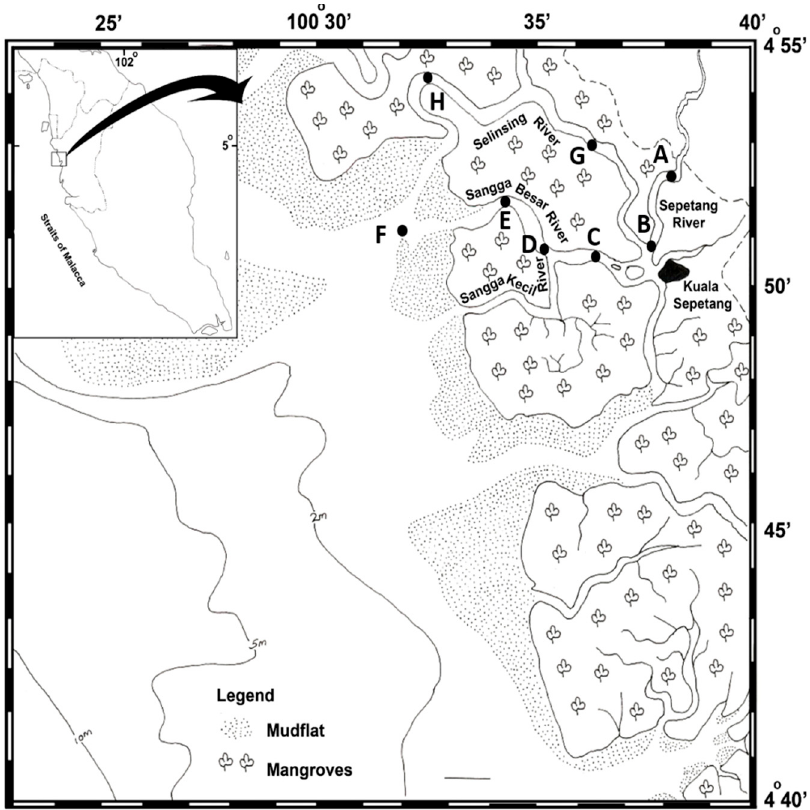
Figure 1. Locations of the eight sampling stations ( A – H ) along the Sepetang, Sangga Besar